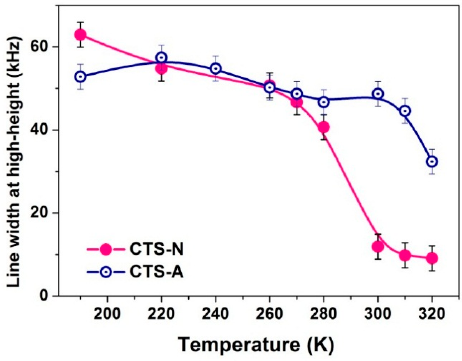
Figure 5. Line width at half height of the narrow components of the solid-echo spectra for CTS-N (Figure 4).